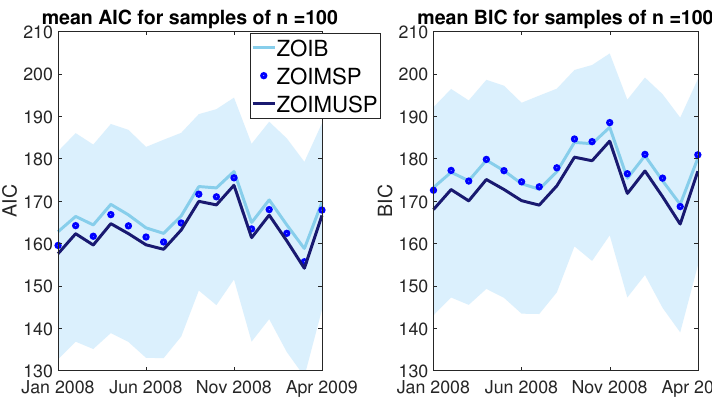
Figure 12. The bootstrap estimated mean of the AIC and BIC for ZOIB, ZOIMSP, and ZOIMUSP models for a sample size of n = 100. The shaded area represents a 90% confidence interval for the mean of the ZOIMUSP model.